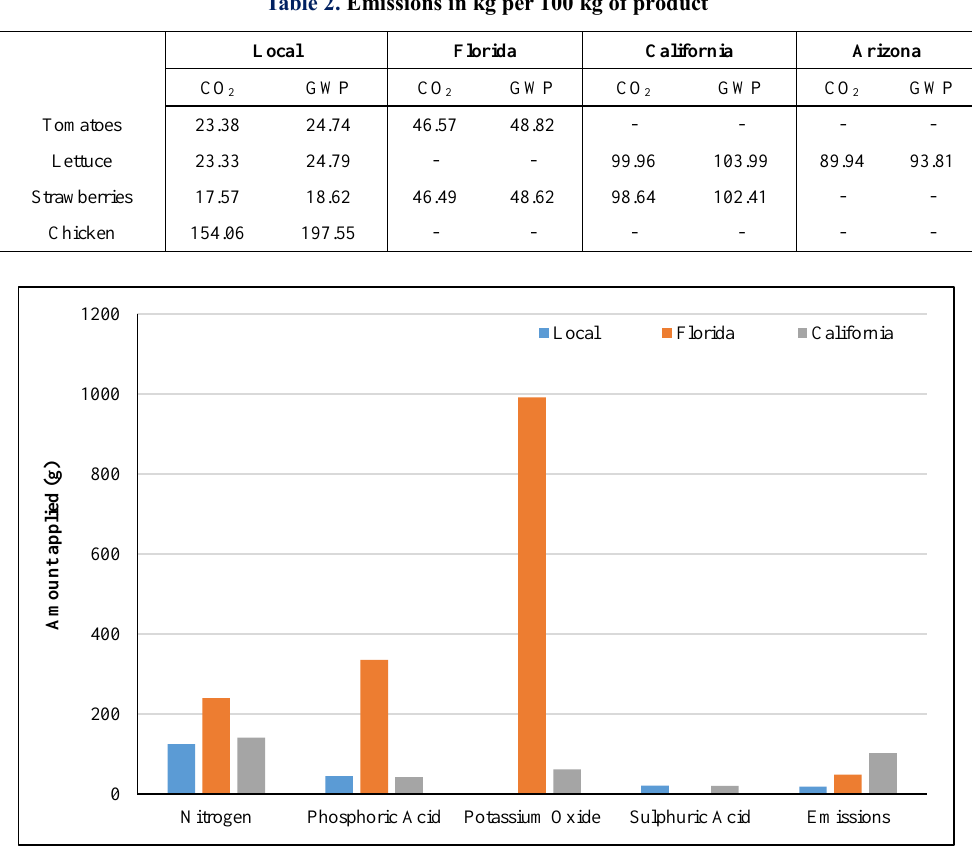
Figure 5. Chemical fertilizer use in strawberry production.